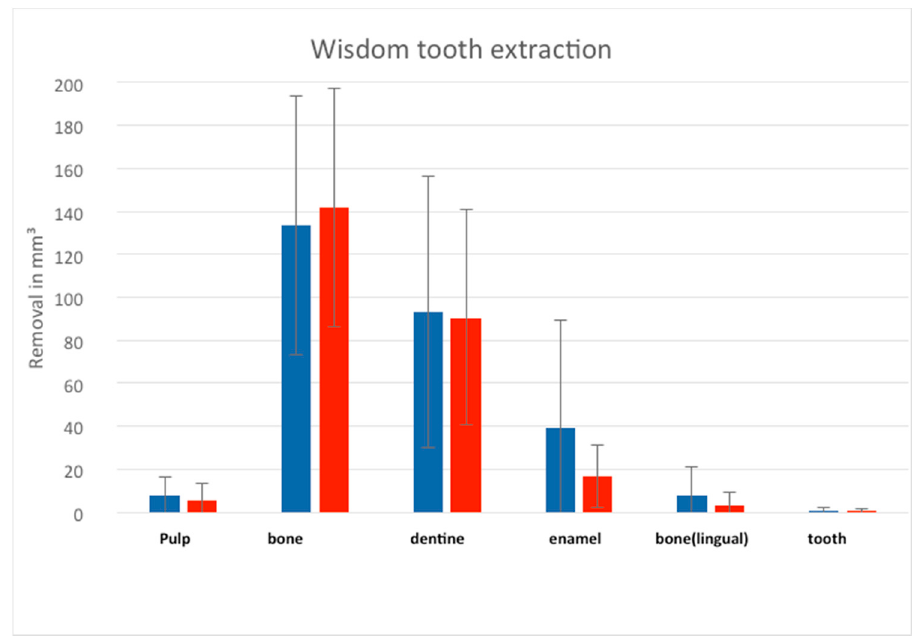
Figure 6. The removal of the parameters (pulp, bone, dentine, enamel, bone lingual and tooth) during the virtual removal of the wisdom tooth in the left lower mandible; blue: students; red: dentists, without any significances.